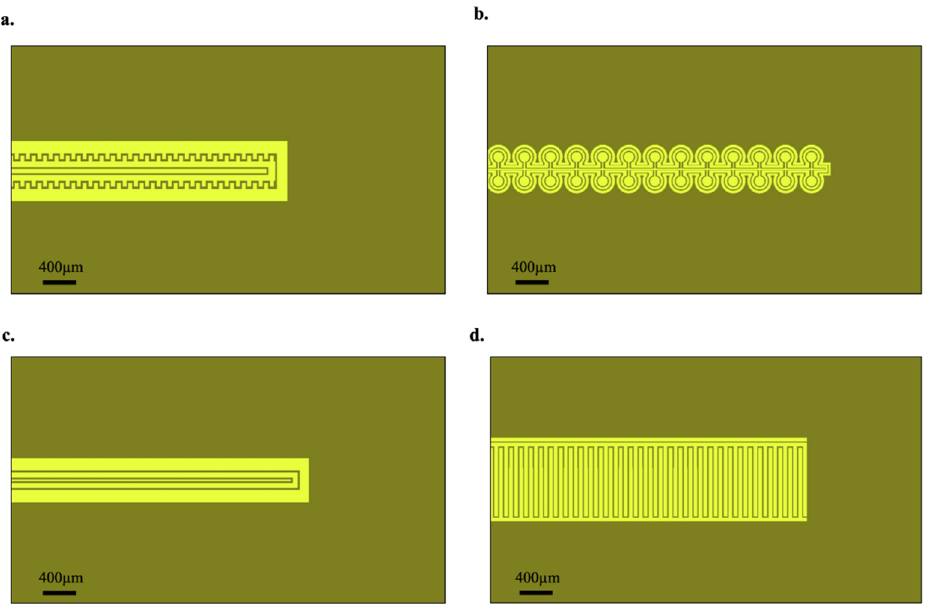
Figure 2. Sensor electrode geometries. ( a ) Electrode design designated as “serrated”, featuring a sawtooth-like counter electrode layout. ( b ) Electrode design designated as “omega” due to its working electrode design. ( c ) Electrode design designated as “basic”, featuring a simpler rectangular working electrode design. ( d ) Electrode design designated as “IDE” due to its interdigitated electrodes.